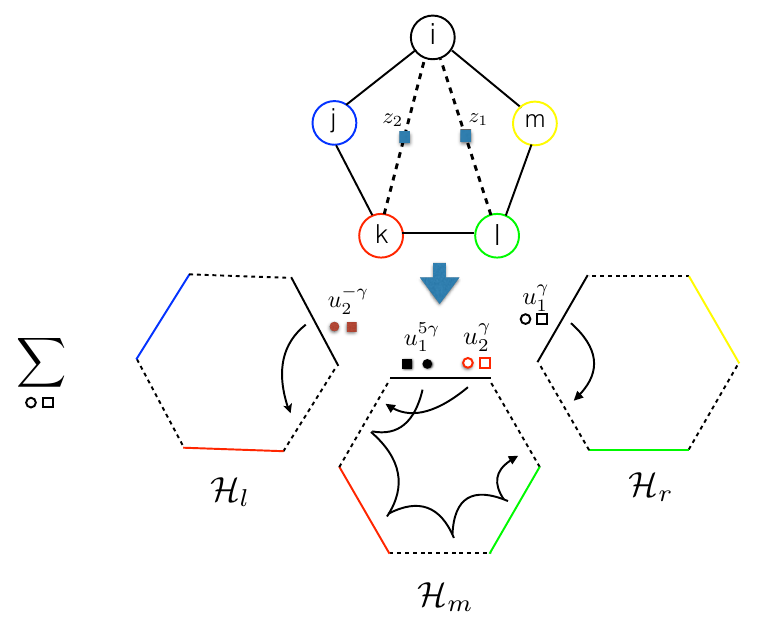
Figure 5 . The computation of the two-particle contribution. At one-loop, it was computed in [36]. The calculation involves three hexagons. The left ( ) and right ( ) hexagons contains only one H l H r mirror particle and they contribute only with a possible sign. The middle ( ) hexagon has two H m particles and its computation is non-trivial as it involves a dynamical factor plus the mirror-mirror bound state S -matrix. The way of contracting the indices of the mirror particles is shown in the (cid:12)gure 6. To glue the hexagons one sums over a weighted complete set of mirror states and the empty and solid circles and squares of the same color correspond to a pair of conjugate